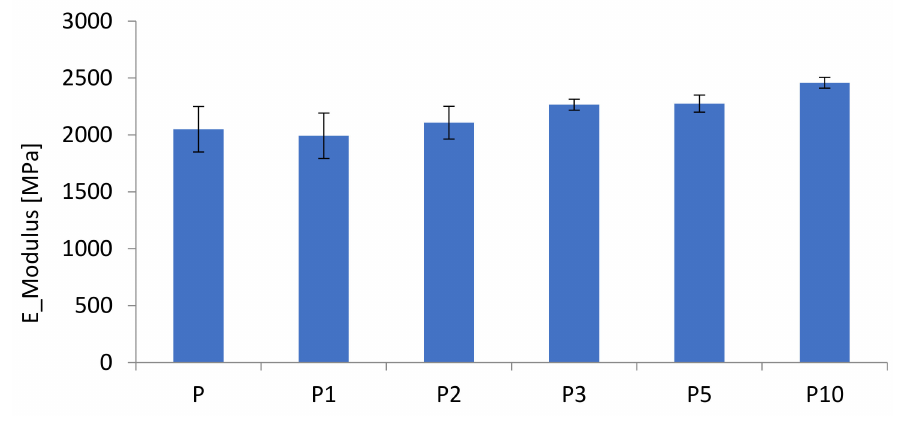
Figure 1. Tensile strengths of the biocomposites.